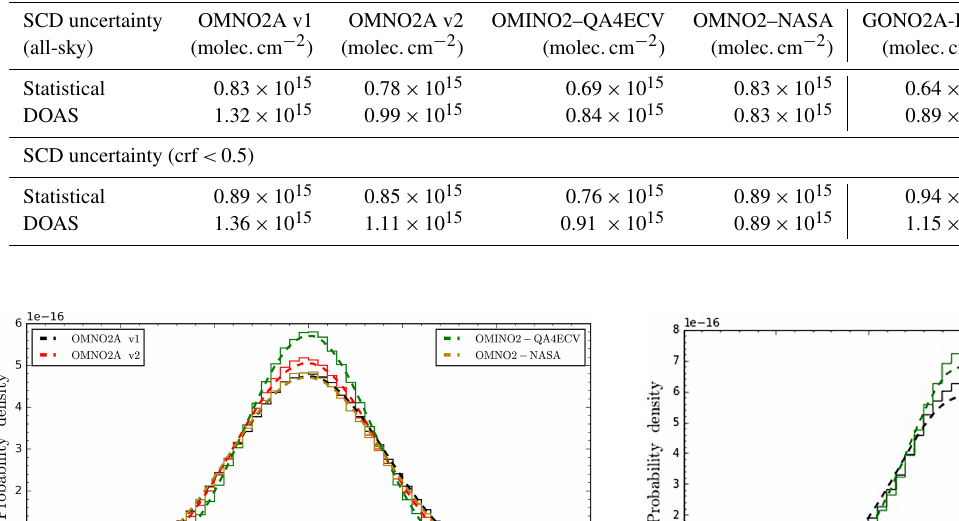
Table 4. Statistical and DOAS uncertainty estimates of OMI NO 2 SCDs for OMNO2A v1, v2, OMINO2–QA4ECV and OMNO2–NASA algorithms, and of GOME-2A NO 2 SCDs for GONO2A-BIRA and GONO2A–QA4ECV algorithms, for the Pacific orbit from day 1 of January, April, July, and October 2005–2015 for all-sky conditions (top panel) and clear-sky conditions (cloud radiance fraction < 0.5) (bottom panel). The cloud radiance fraction (crf) is the fraction of the radiation from the cloudy part of the pixel.